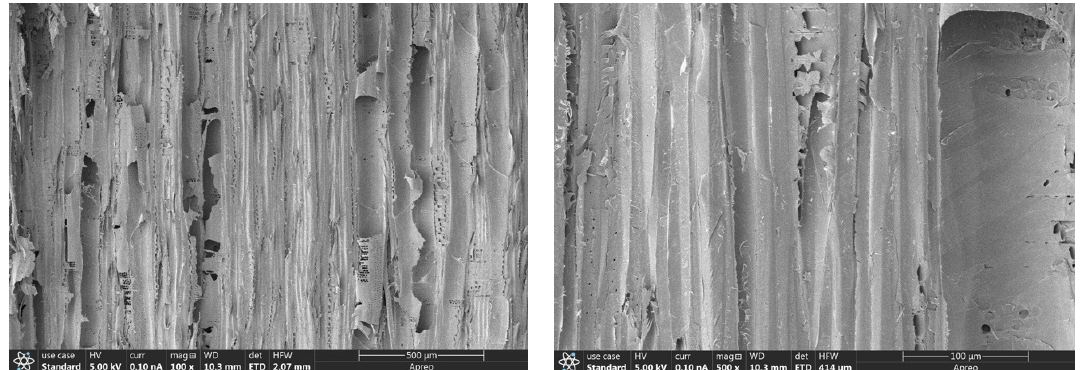
Figure 10. The internal morphology of the dried blocks.